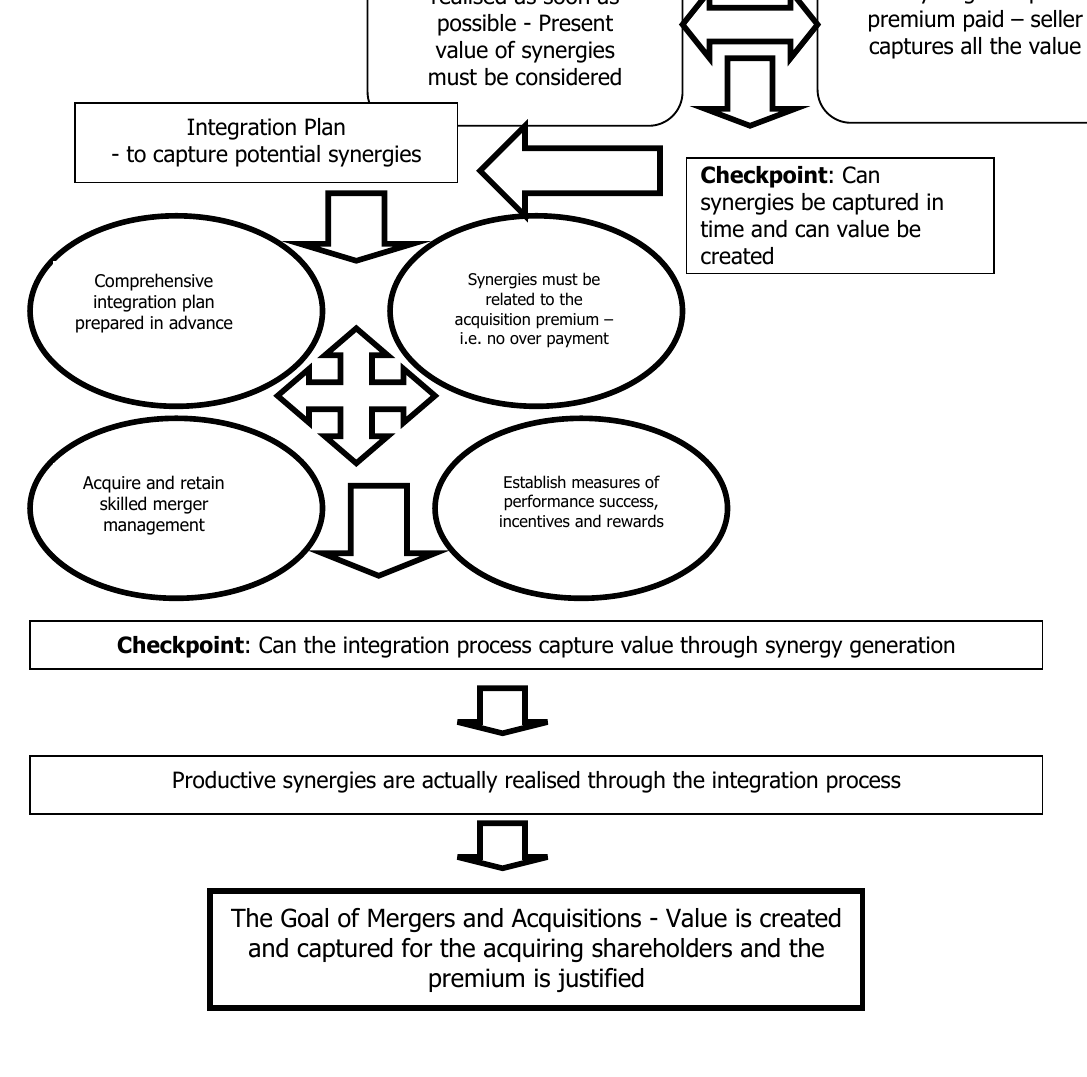
Figure 1: The value creation through synergy evaluation